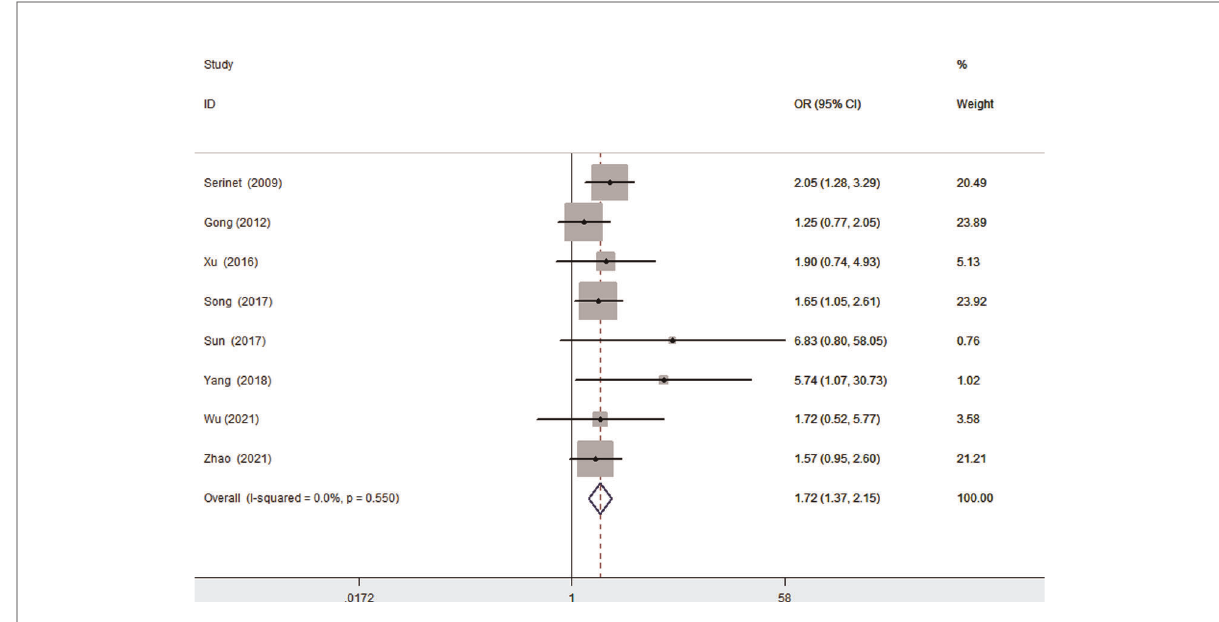
FIGURE 5 Forest plot for NLSR of ≤ 90 days vs. >90 days group. NLSR, native liver survival